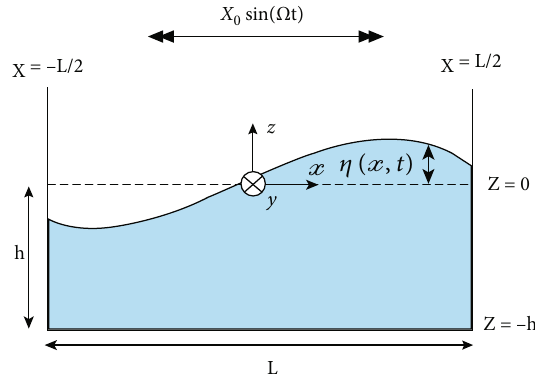
Figure 1: The coordinate system of the